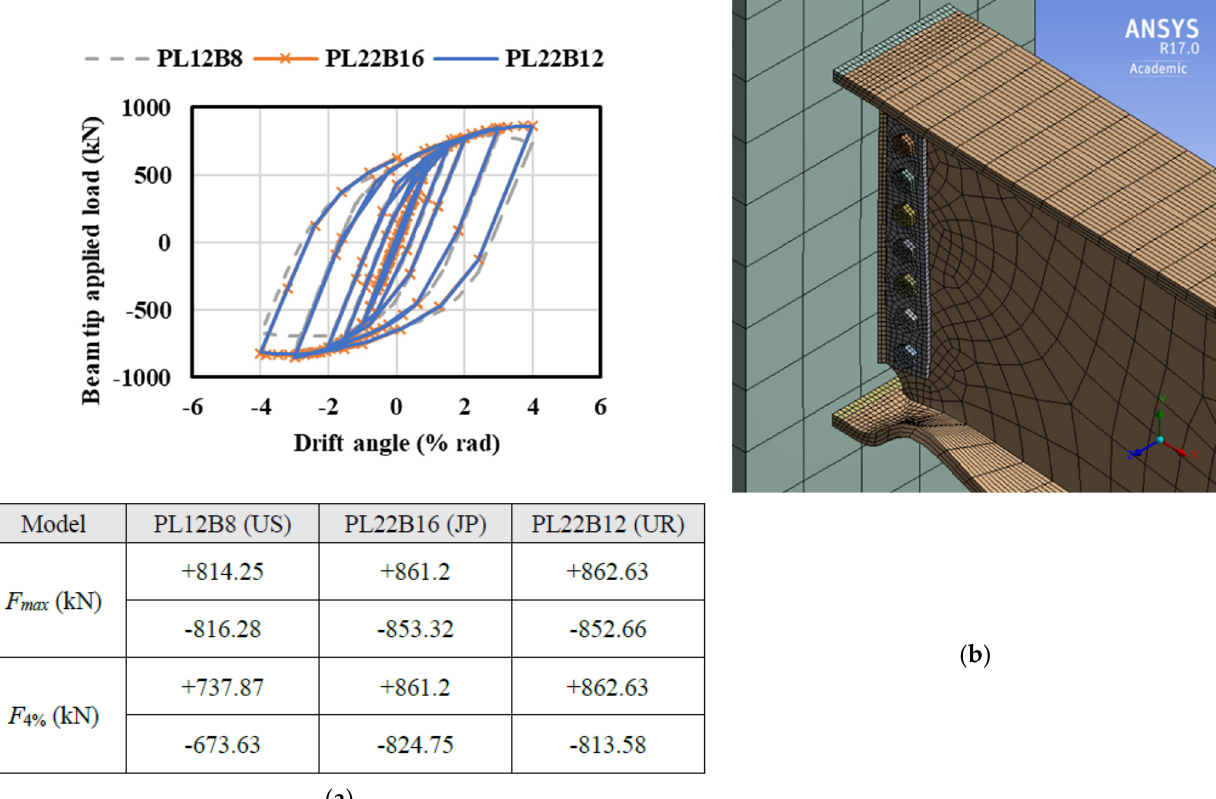
Figure 7. FEM simulation of design examples: ( a ) load-displacement curves, and ( b ) local buckling of bottom beam flange (PL12B8 model).